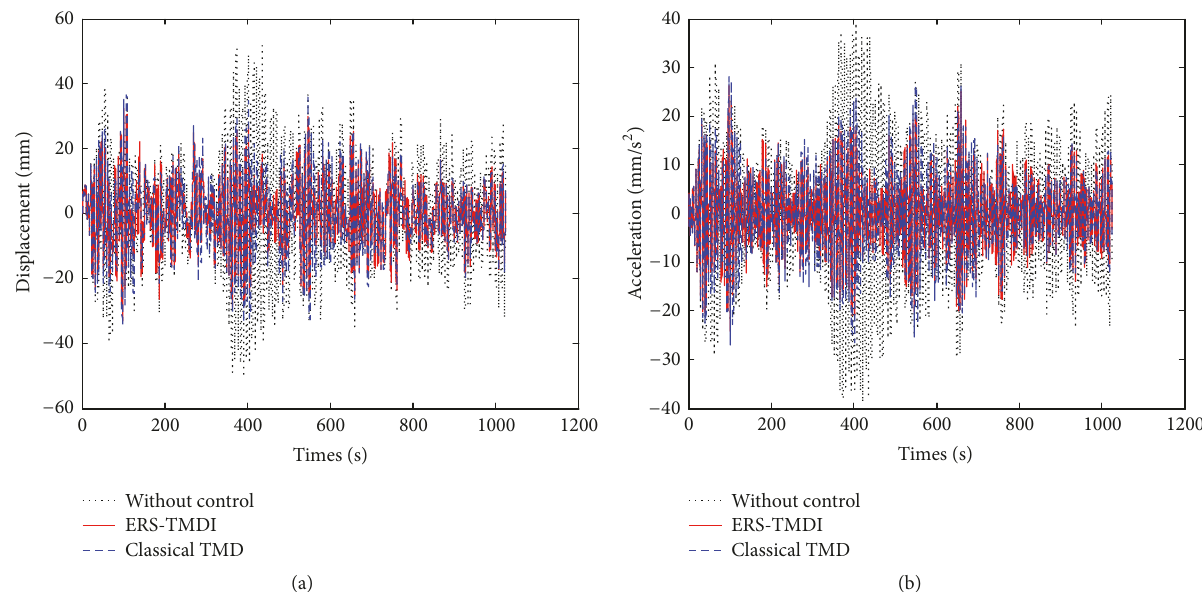
Figure 7: Time-history responses of (a) displacements and (b) accelerations of the primary structure: comparison between classical TMD and